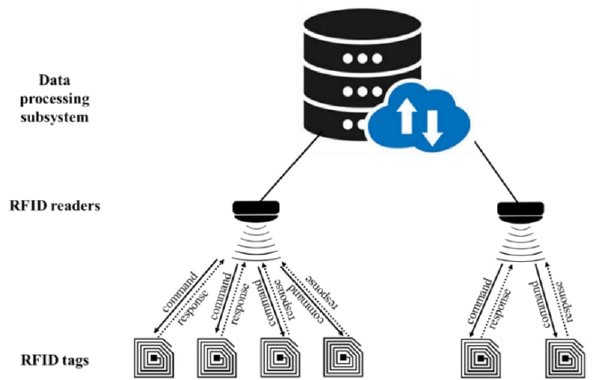
Figure 17. Typical RFID system reproduced with permission from Lionel, RFID-based Localization and Tracking Technologies , published by IEEE,